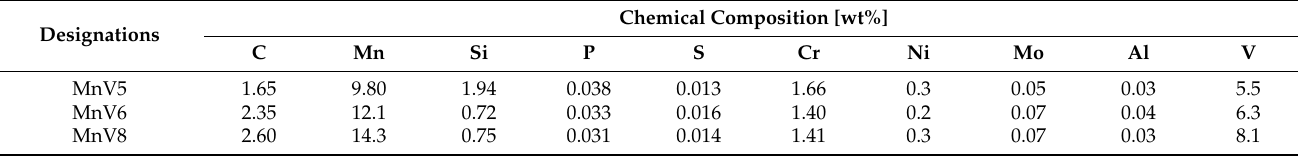
Table 2. Chemical composition of the tested high-manganese cast steel.